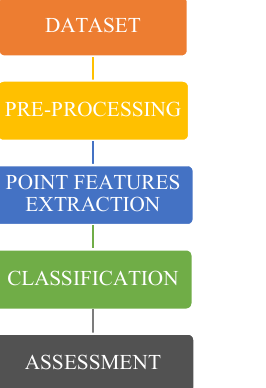
Figure 1. The workflow of the proposed methodology